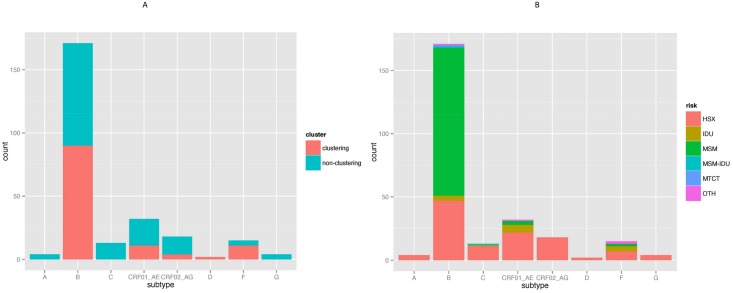
HIV Subtype in the South-East Austrian Cohort.2A. Comparison between clustering and non-clustering populations by HIV subtype. 2B. HIV Subtype by Risk factors in the South-East Austrian Cohort. Legend: HSX, heterosexual contact; IDU, injection drug use; MSM, men who have sex with men; MTCT, mother to child transmission; OTH, other.